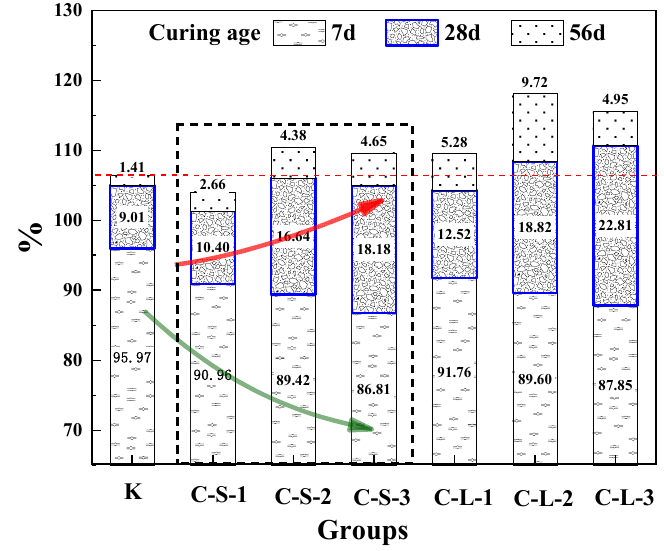
Figure 17. Healing rate of flexural strength.